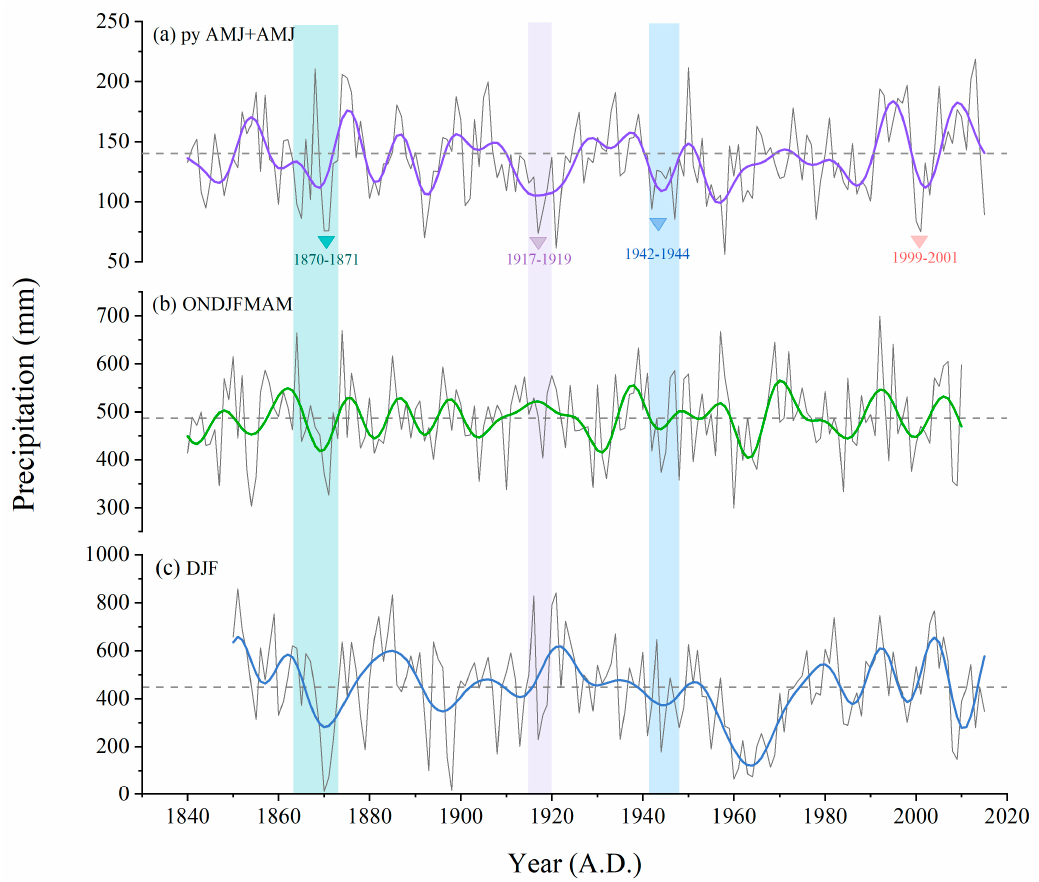
Figure 5. Comparison between the annual and decadal (bold lines) variations of the reconstructed spring precipitation py AMJ + AMJ and two precipitation reconstructions from the Zagros Mountains, west Iran. ( a ) Reconstructed precipitation py AMJ + AMJ in the present study, ( b ) October to May precipitation in the central Zagros Mountains during 1840–2010 [34], ( c ) December to February precipitation in the southern Zagros Mountains during 1850–2015 [5]. Colored bars indicate historical famine and drought periods.